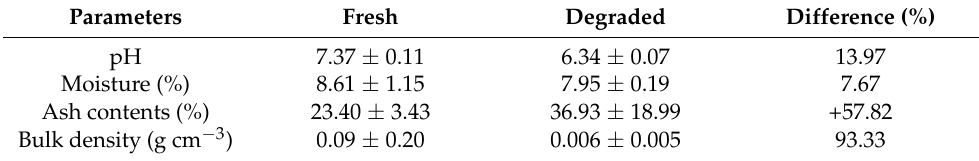
Table 1. Physical-chemical characterization of fresh and degraded mulches (after 70 days).